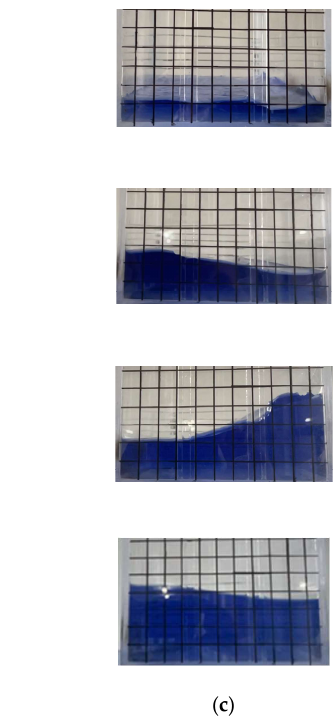
Figure 2. The overall drawing of the experimental model. ( a ) The overall. ( b ) Placement scheme of integral water tank. ( c ) The integral water tank with different water levels when water sloshes on the top floor.